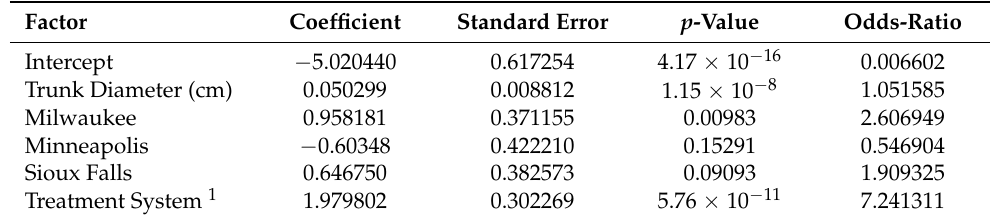
Table 3. Logistic model testing the effect if an injected green ash ( Fraxinus pennsylvanica Marshall) had a wound (n = 365).